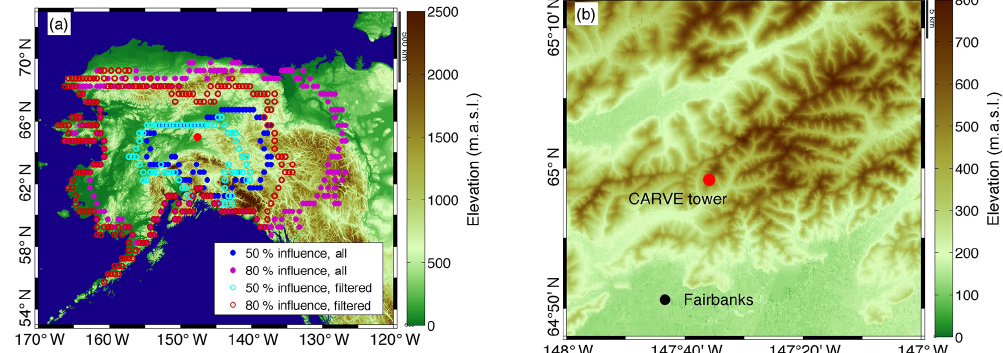
Figure 1. CO 2 and CH 4 measurements from the CARVE tower (filled red circle, both panels) have a high sensitivity to the boreal forests and lowlands of interior Alaska as shown by the 50% (blue) and 80% (purple) surface influence contours for the average WRF-STILT influence functions calculated for midafternoon averages over the period 2012–2014 (a) . The same influence contours (cyan and red open circles) are shown for the subset of footprints used in the flux analysis after filtering. Note that the elevation scale differs between the panels. Elevation data in (a) are from NOAA’s National Geophysical Data Center Global Land One-kilometer Base Elevation (GLOBE) database (http://www. ngdc.noaa.gov/mgg/topo/report/globedocumentationmanual.pdf; GLOBE Task Team and others, 1999). High-resolution elevation data in (b) are from the Advanced Spaceborne Thermal Emission and Reflection Radiometer global digital elevation map (ASTER GDEM), a product of the Ministry of Economy, Trade and Industry, Japan (METI) and